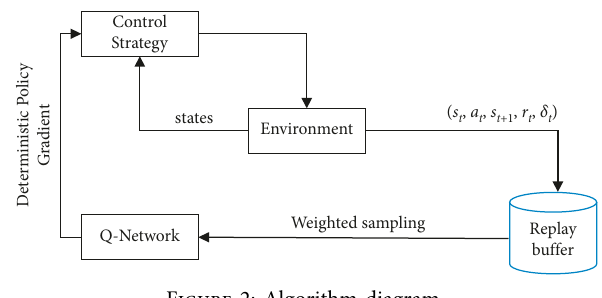
Figure 2: Algorithm